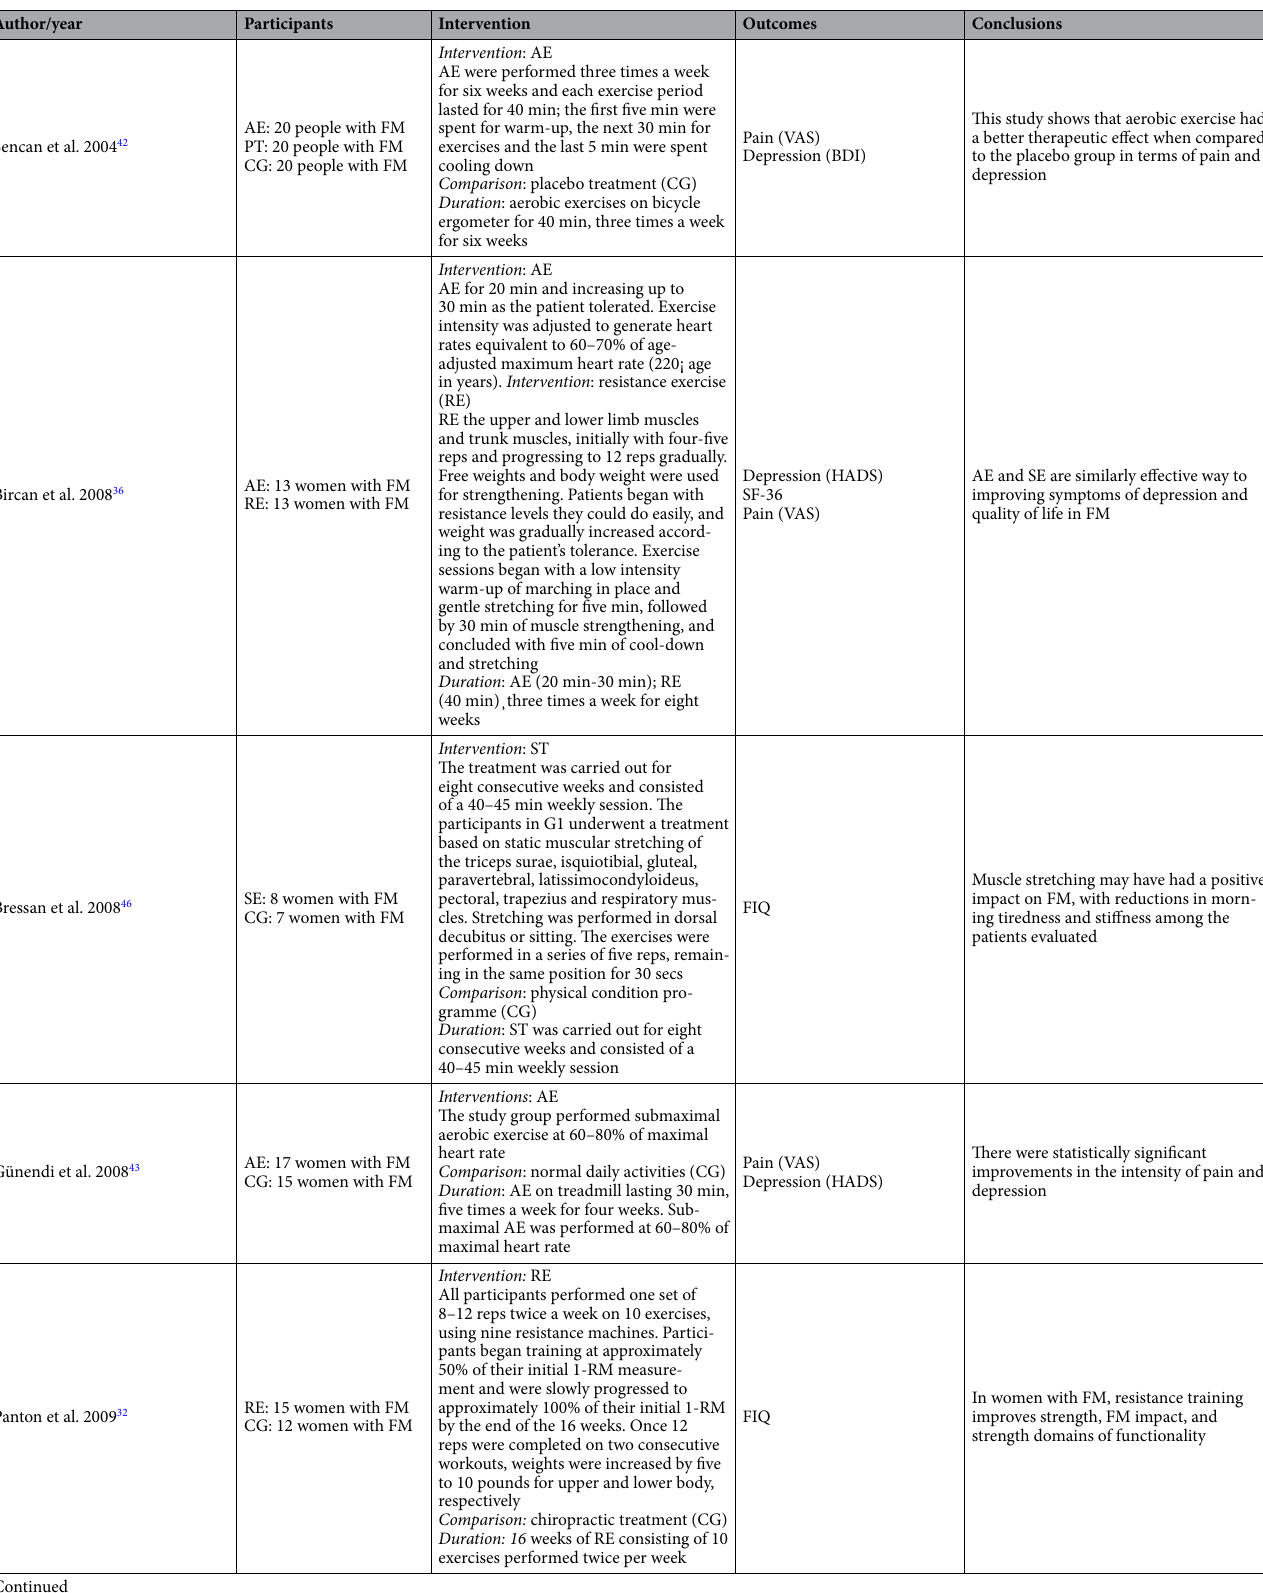
strength domains of